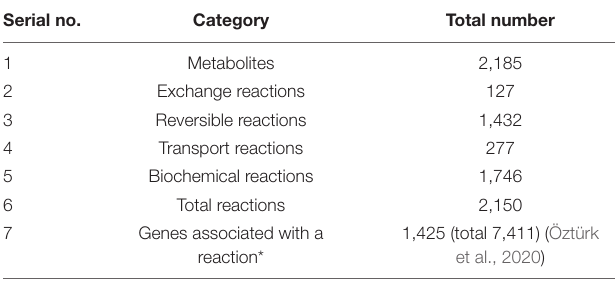
TABLE 1 | Functional details of the Variovorax sp. SRS 16